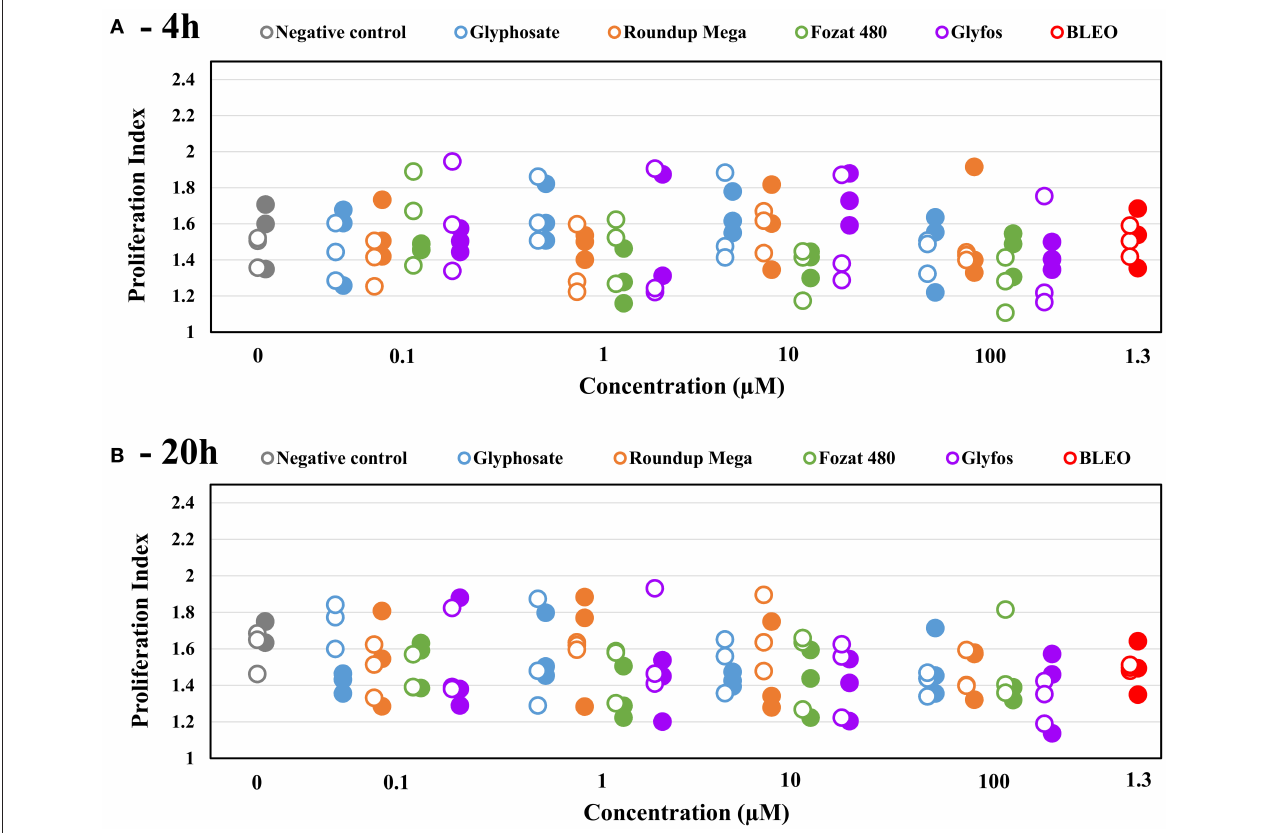
FIGURE 4 | Proliferation index (PI) induced by 4-h (A) and 20-h (B) exposure to sub-cytotoxic concentrations of glyphosate and GBHs without ( ◦ ) and with (•) metabolic activation (S9) in human mononuclear white blood cells, detected by cytokinesis-block micronucleus assay. Data points are results of individual experiments. Statistically significant change was determined by comparing the proliferation index induced by various doses of test chemicals to the background level of untreated cells by ANOVA with Dunnett’s post hoc test. The same test was used to detect statistically significant difference in the proliferation index between S9-treated and S9-untreated cells induced by the same concentration of test